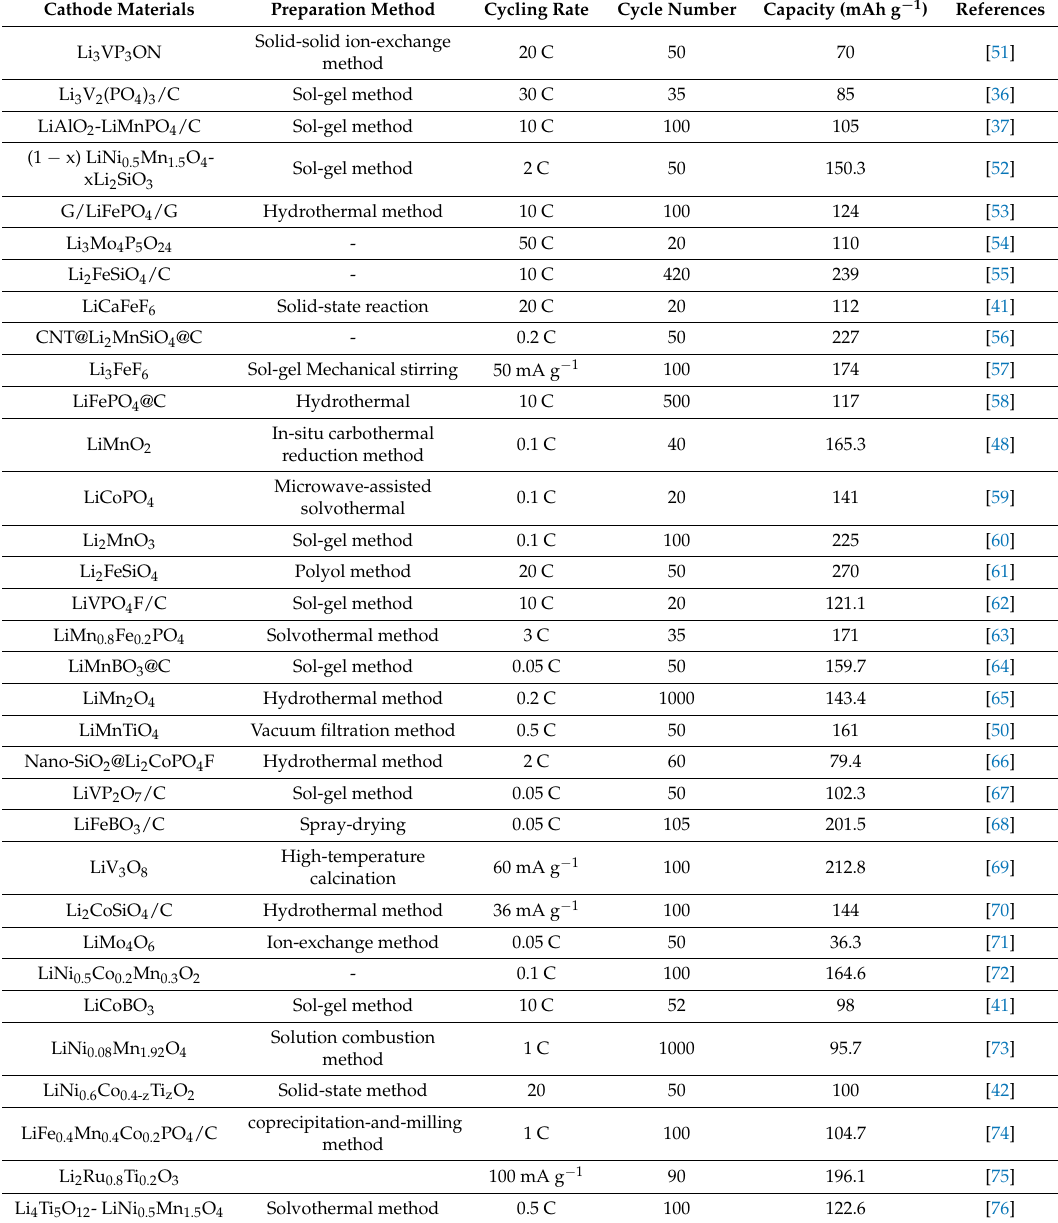
Table 1. Comparison on the performance of three-dimensional Li-ion battery